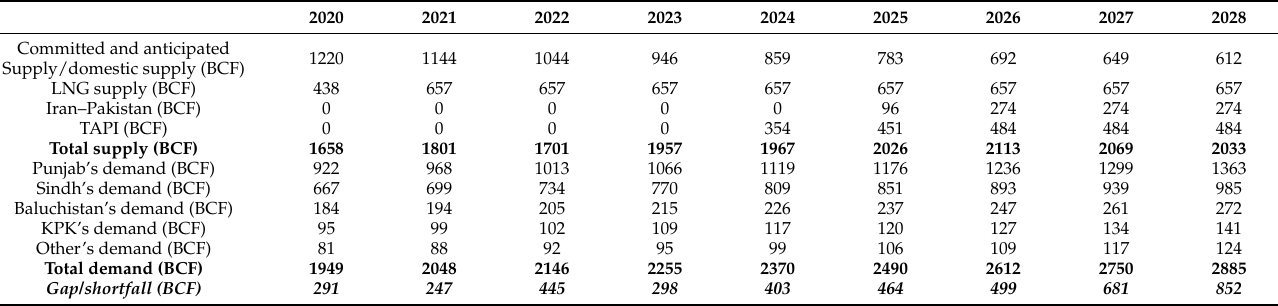
Table 2. Gas demand and supply scenario from 2020–2028 [46].